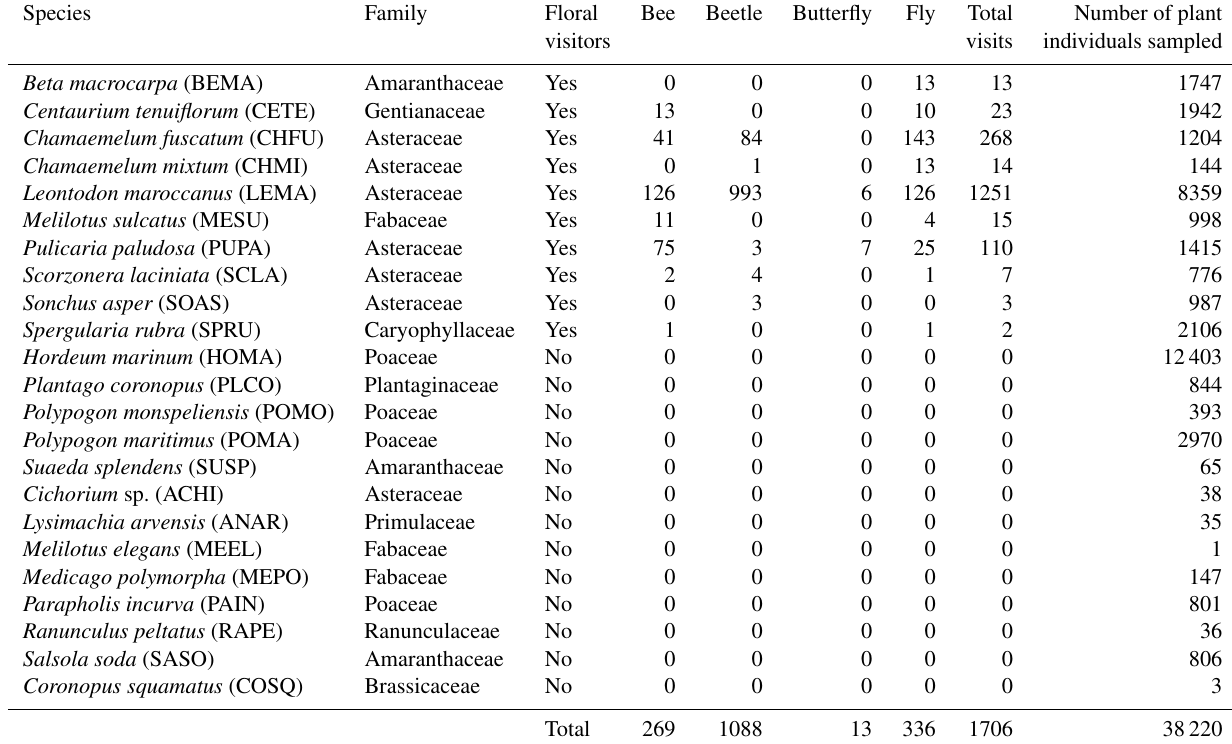
Table A1. List of species observed in the Caracoles estate in 2020. The code and taxonomic information of the plant species are provided. Also, the number of visits of each floral visitor group by plant species is recorded. Sample sizes represent the abundances of each species that we measured in the field, and they are correlated with their natural abundances in the site study. In these data the butterfly visits are included; however, due to the low number of visits of that group (only 13 visits), we decided to exclude these data for further